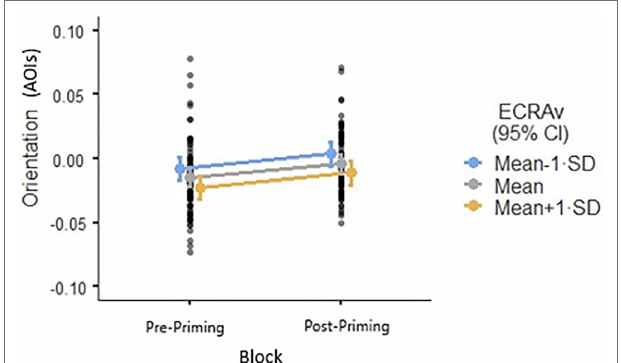
Orientation Indexes (AOIs). Y-axis values represent AOIs where a negative value indicates attentional disengagement, and a positive value indicates attentional engagement. A value of 0 indicates no attentional